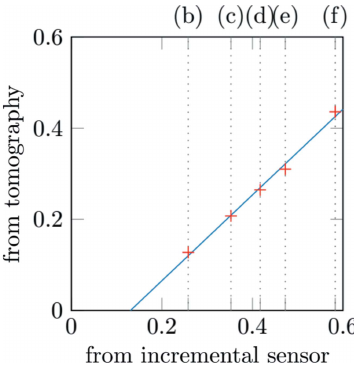
Figure 14 Re-adjustment of the punch displacement